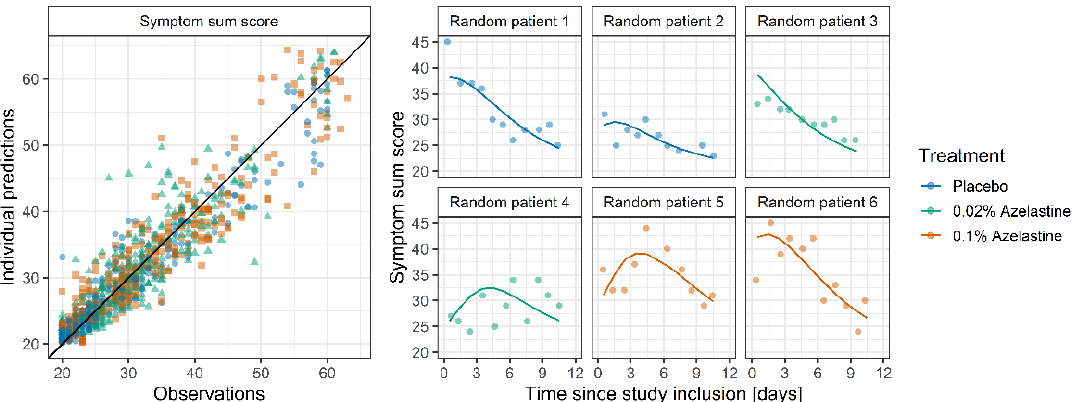
Figure 3. Goodness ‐ of ‐ fit plots for the symptom score model ( left ) showing individual predictions vs. observations. The black line indicates the line of identity. Exemplary plots ( right ) for two ran ‐ domly drawn patients per study arm. Points indicate observations. Lines indicate individual model